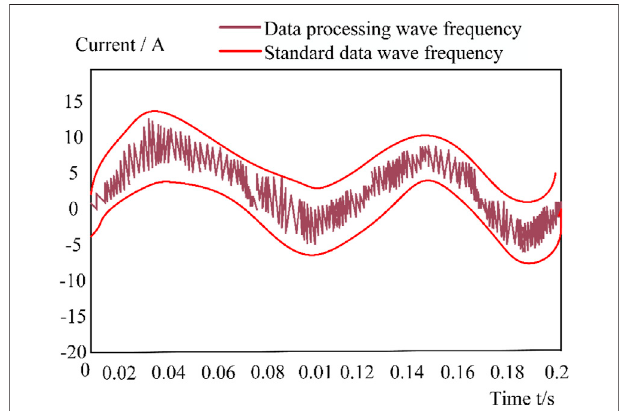
FIGURE 4 | Wave frequency diagram of discrete dynamic system when processing data.